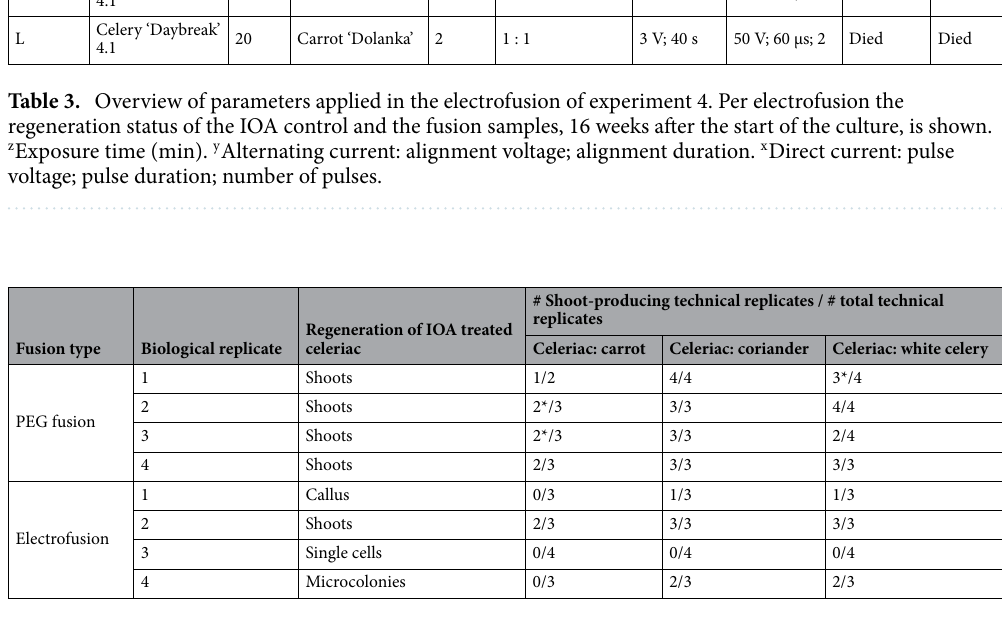
Table 4. Asymmetric electrofusion and PEG fusion between ‘Diamant’ celeriac (acceptor) and ‘Parmex’ carrot, coriander or ‘WL253’ white celery (donors) protoplasts performed in experiment 5. The number of shoot-producing technical replicates / number of total technical replicates, per fusion type and independent repeat are depicted. The data are recorded 12 weeks after the start of the culture. *One replicate contaminated before it was able to produce